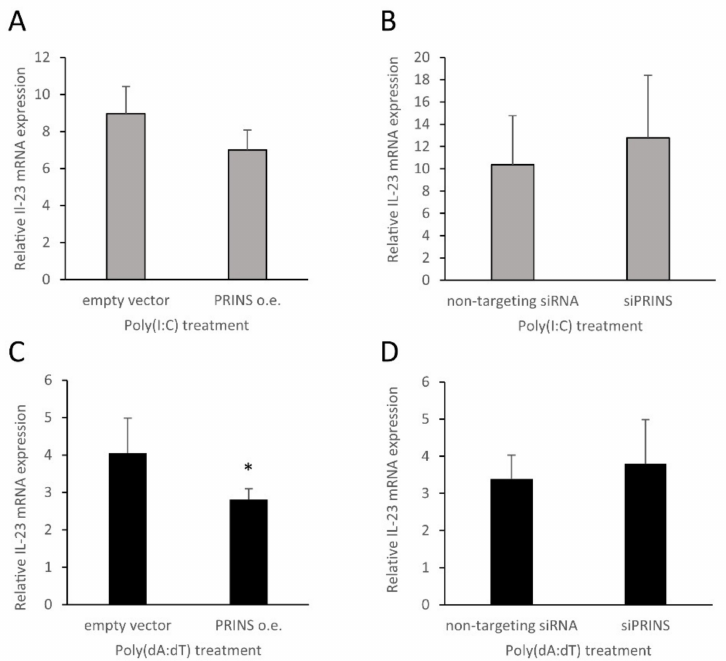
Figure 7. The effect of PRINS overexpression ( A , C ) and silencing ( B , D ) on the IL-23 mRNA expression upon poly(I:C) ( A , B ) and poly(dA:dT) ( C , D ) treatment. PRINS-overexpressing ( A , C ) or -silenced ( B , D ) cells were transfected with 0.666 µ g/mL poly(I:C) or 1 µ g/mL poly(dA:dT) Relative IL-23 mRNA levels were determined by the ∆∆ Ct method, normalized to GAPDH mRNA expression and compared to mock-transfected samples. Data are presented as means of eight ( A ), fifteen ( C ) and three ( B , D ) independent experiments ± SD. Statistical significance was assessed by one-tailed, paired Student’s t -test, * p < 0.05.